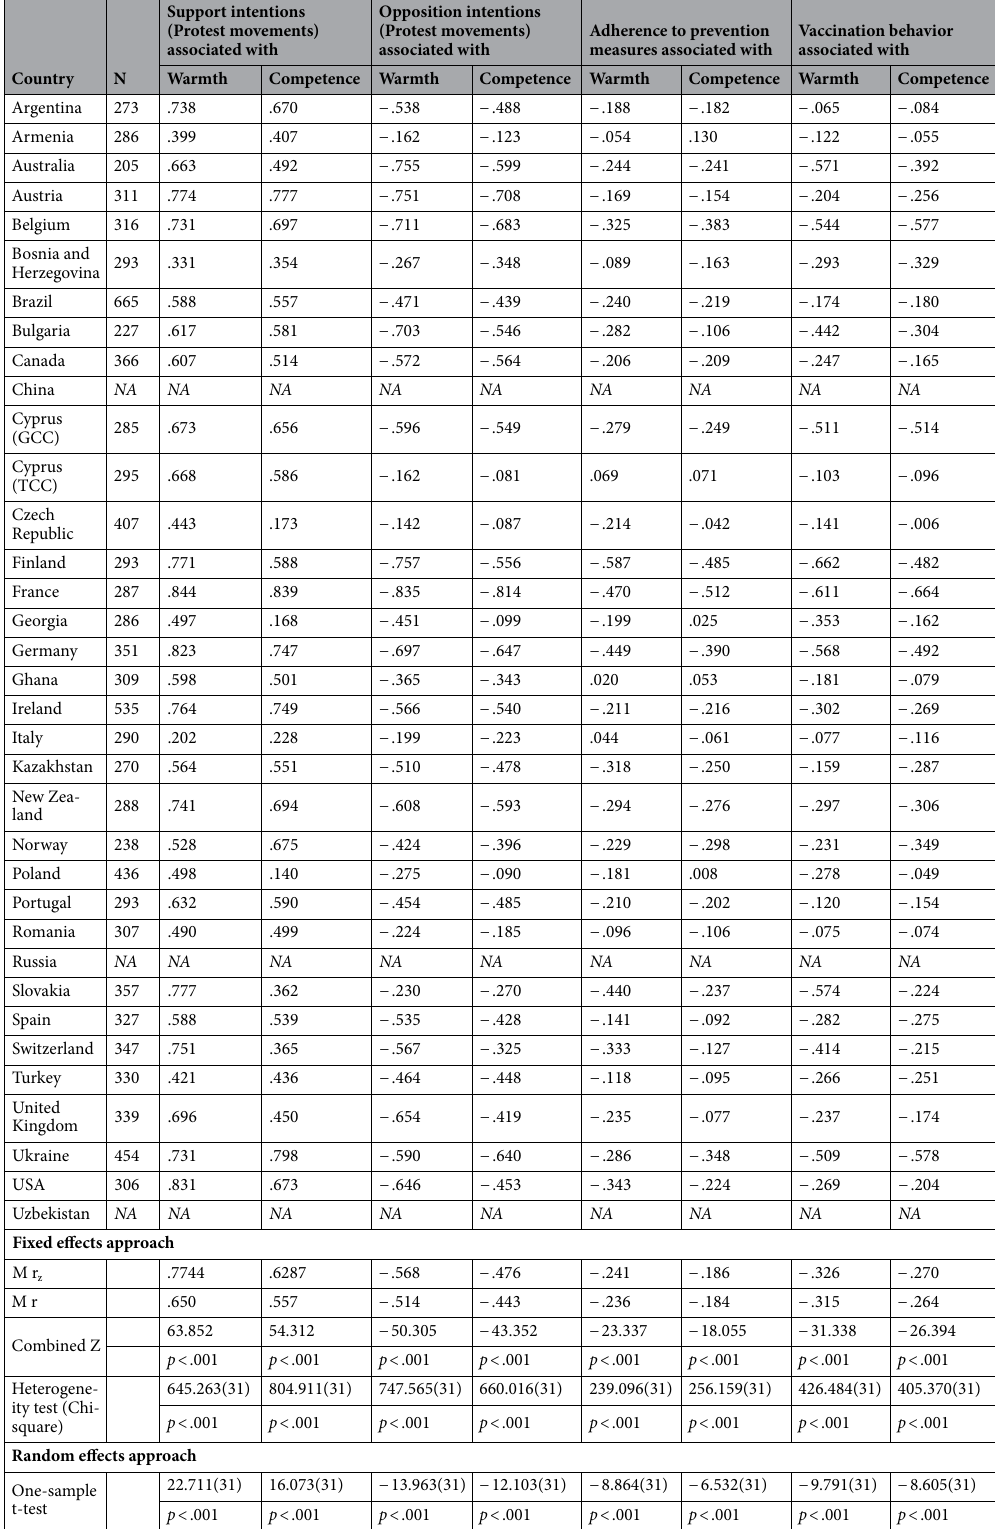
Table 3. Relationships between warmth and competence perceptions of the protagonist ‘protest movements’ with pandemic-related behavioral intentions and behaviors within and across 35 countries. TCC